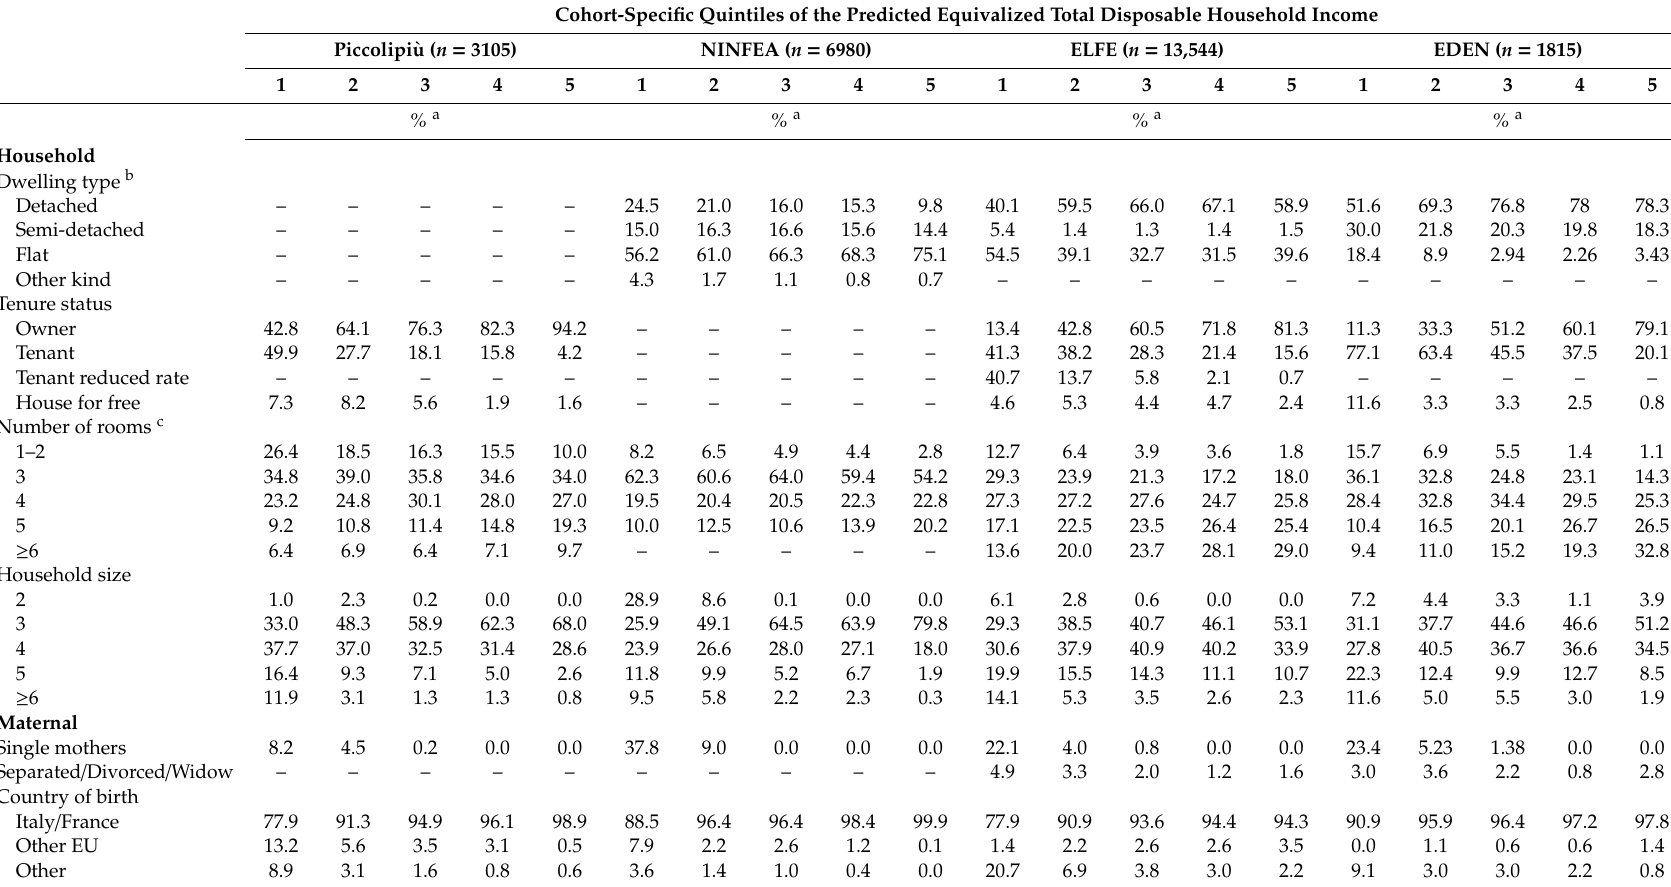
Table 1. Description of the cohort-specific predicted income quintiles in terms of the available